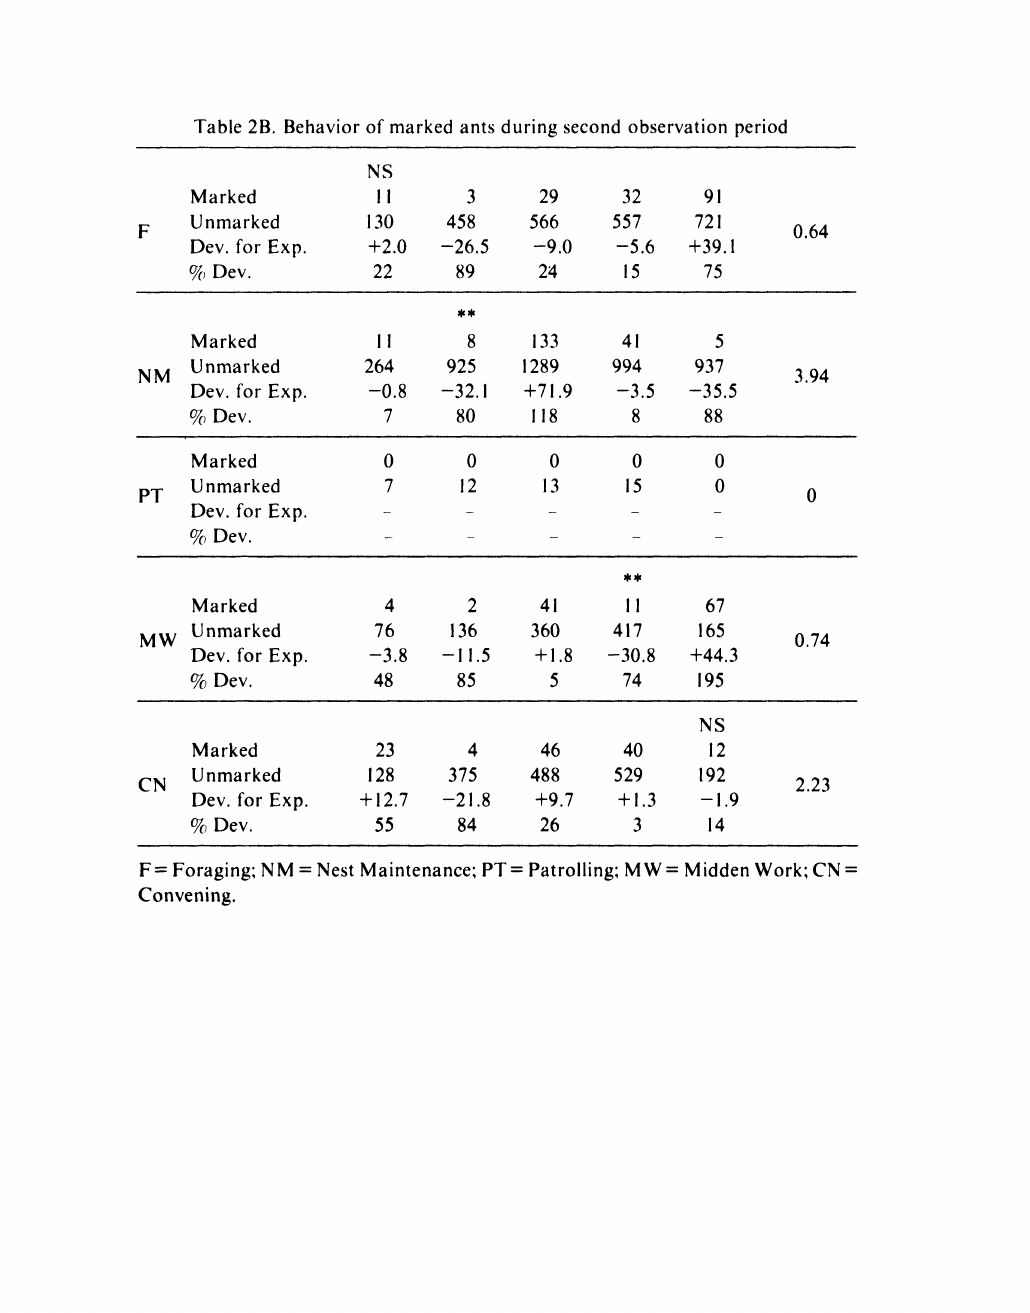
Table 2B. Behavior of marked ants during second observation